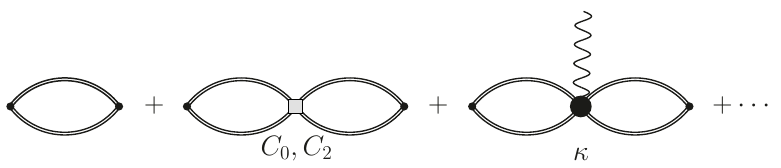
Figure 3 . Two-point function of the composite field φ 2 ( x ) . Double lines denote the full one-particle propagator in the external field, see figure 4. The diagrams, in which the external field is attached to the four-particle vertex, are explicitly included.